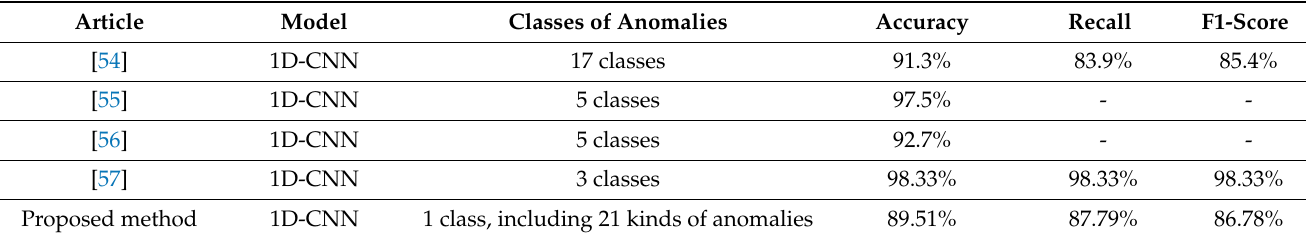
Table 6. Comparison with studies performed using 1D-CNN on the MIT-BIH Arrhythmia